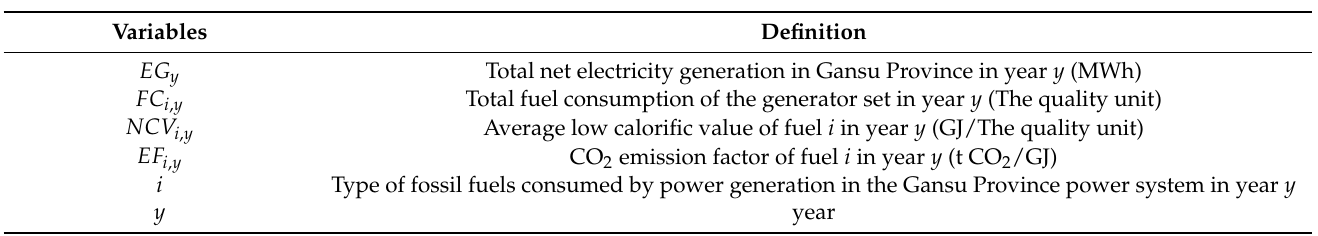
Table 2. Definition of various variables in Equation